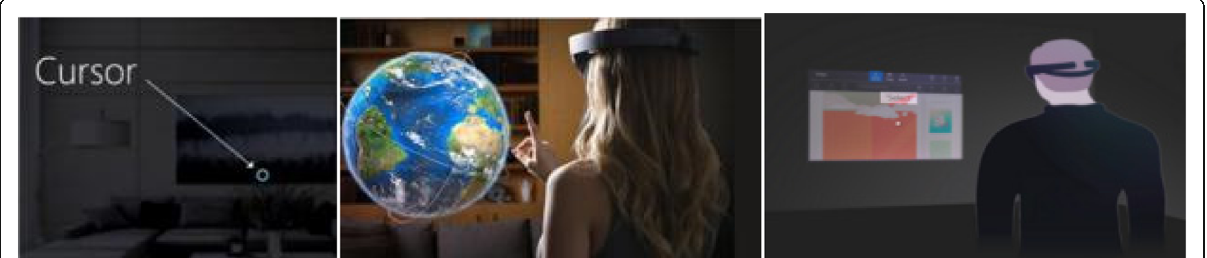
1 shows HoloLens